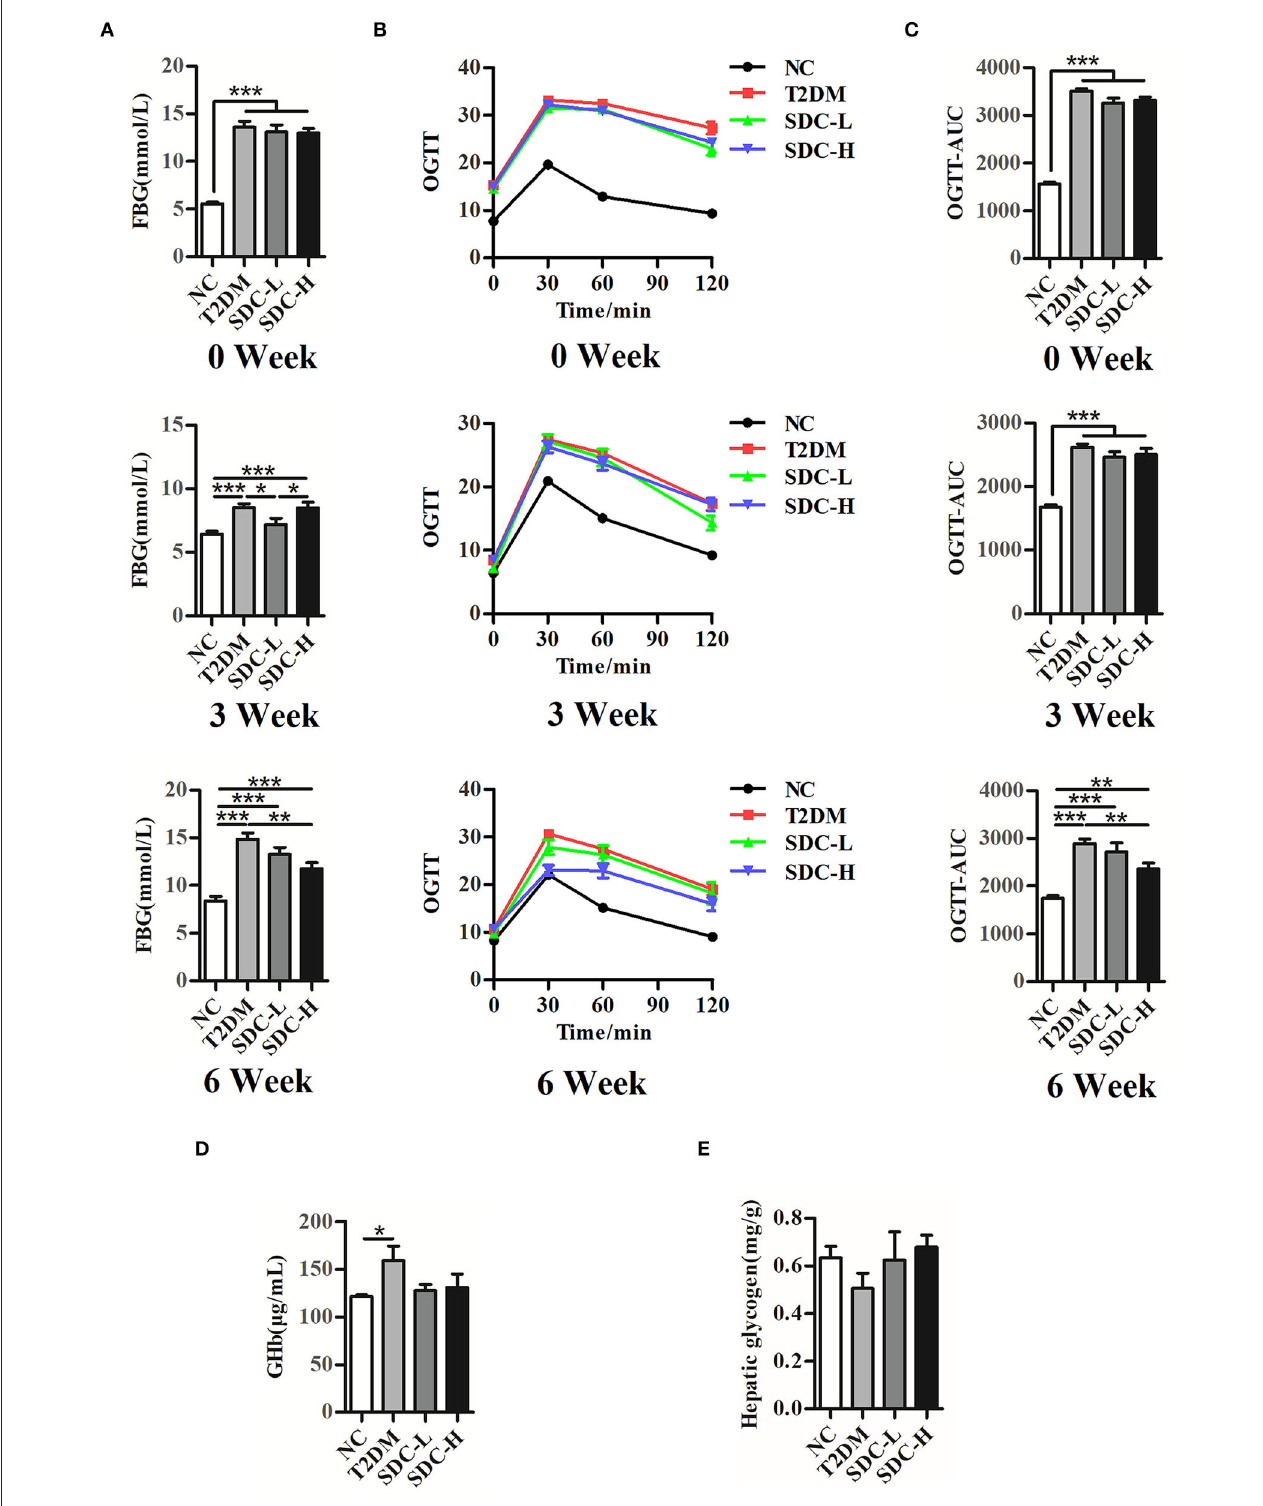
FIGURE 2 | FBG (A) , OGTT (B) , and (C) OGTT-AUC of the mice at 0th, 3rd, 6th week after the intervention begin, n = 11; (D) GHb levels of the mice, n = 8; (E) Hepatic glycogen contents of the mice, n = 5. * P < 0.05, ** P < 0.01, *** P < 0.001.